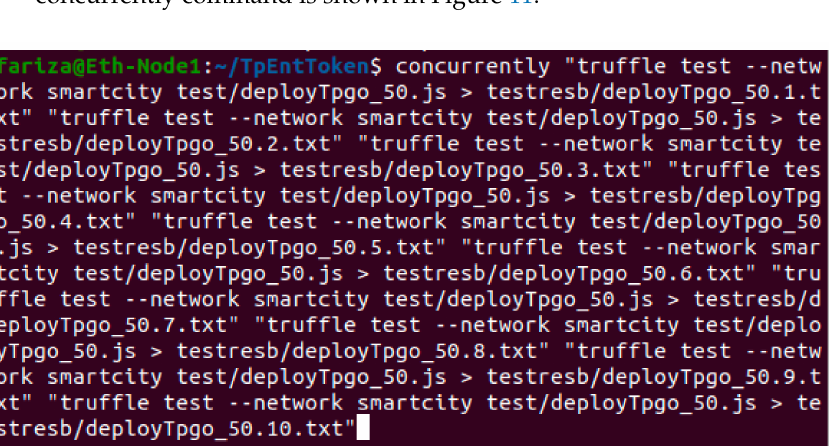
Figure 11. Concurrently-running 10 instances of client Javascript app in parallel.